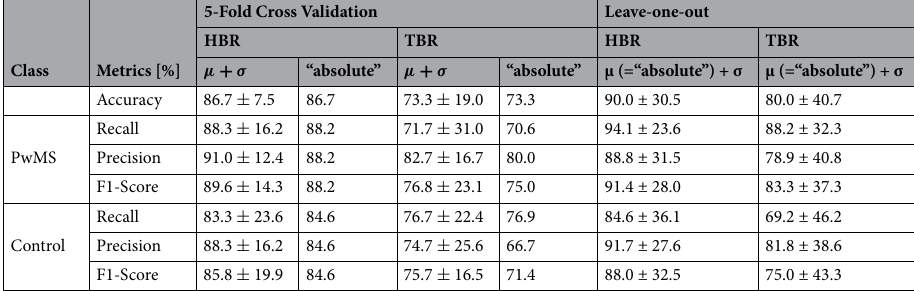
Table 1. Average AdaBoost model performance over the 5 test folds, and total results using the leave-one- out approach, in terms of accuracy, recall, precision, and F1-Score per class, for different sets of features (only HBR features or TBR features). The “absolute” results refer to the scores computed over the total and single confusion matrix obtained by putting together the predictions over the 5 test